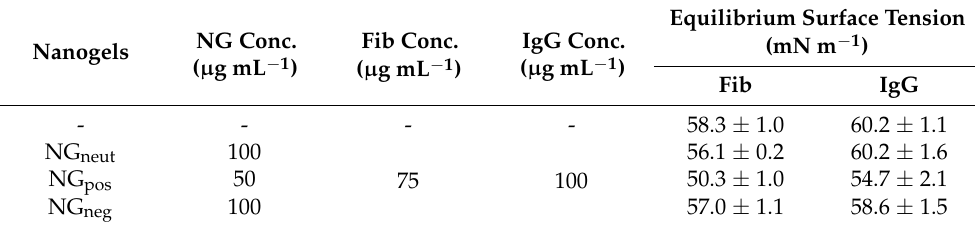
Figure 3. Protein corona studies of NG pos with model proteins Fib and IgG. Dynamic surface tension plots for NG pos (50 μg mL −1 ) with: ( a ) Fib, or ( b ) IgG. Change in equilibrium surface tension of protein samples as a function of the concentration of NG pos are presented for: ( c ) Fib, and ( d ) IgG. Table 3. Equilibrium surface tension values obtained for Fib, IgG, and their mixtures with neu- prepared in PBS (pH 7.4) and analysed at 25 ◦